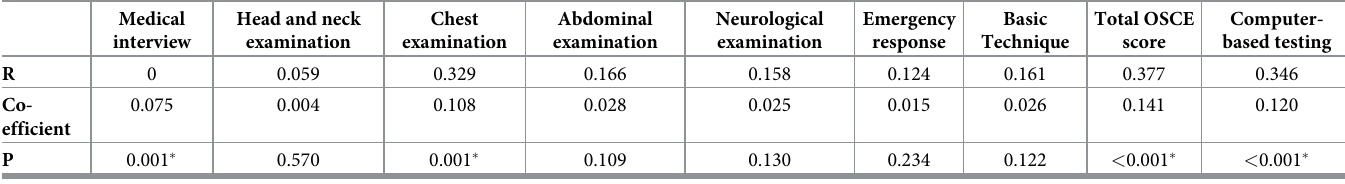
Table 2. Correlations of objective structured clinical examination (OSCE) and computer-based testing scores with clinical clerkship (CC) scores. Medical interview